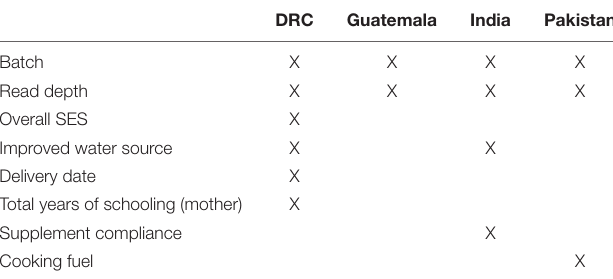
TABLE 1 | List of covariates used in all final models by the